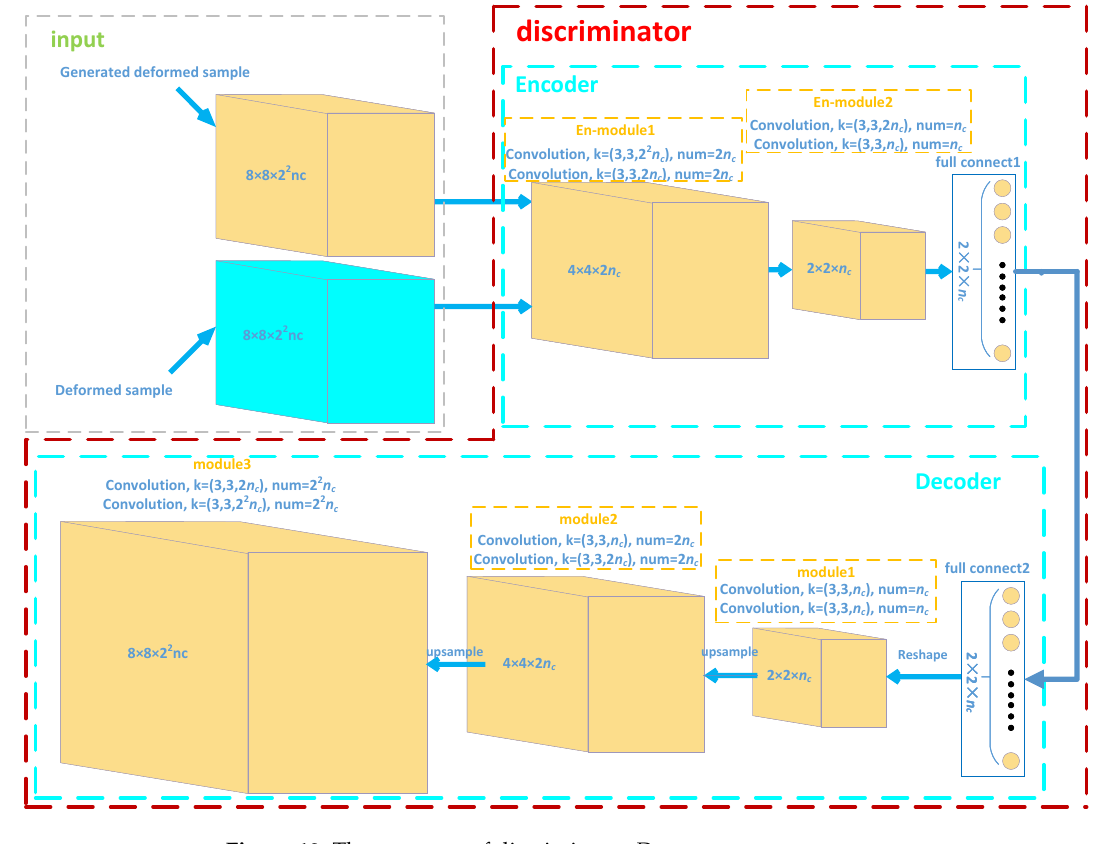
Figure 10. The structure of discriminator D . Table 2. The parameters of the discriminator D